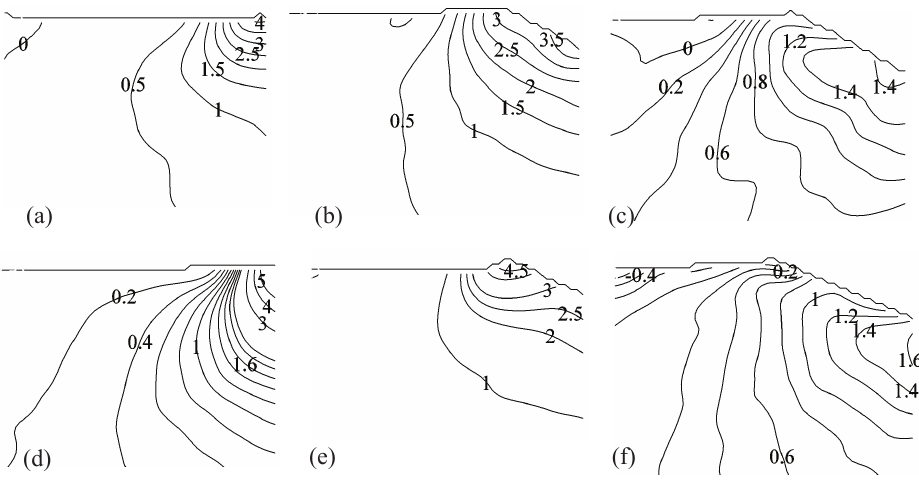
Figure 7. Pressure distribution in the fluid region in kPa for ( a – c ) Light-Short and ( d – f ) Heavy-Short conditions, at different time instants: ( a , d ) t = 1.25 ms; ( b , e ) t = 7.5 ms; and ( c , f ) t = 12.5 ms.